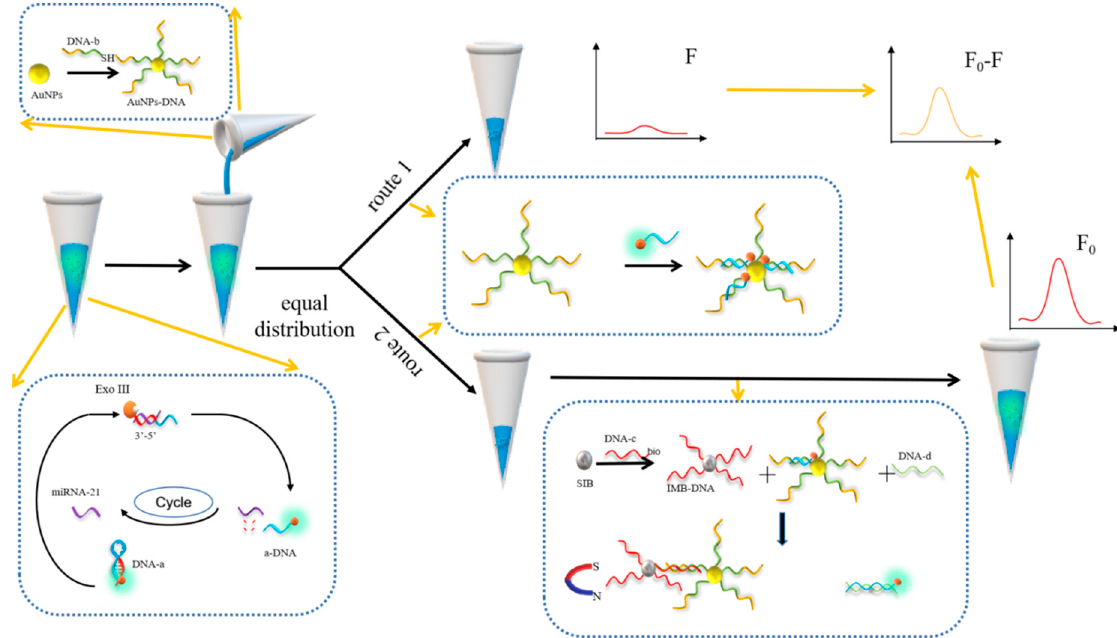
Figure 1. Schematic illustration of the detection of target miRNA-21 using an Exo III-assisted cyclic amplification and AuNPs–DNA quenching fluorophore strategy.